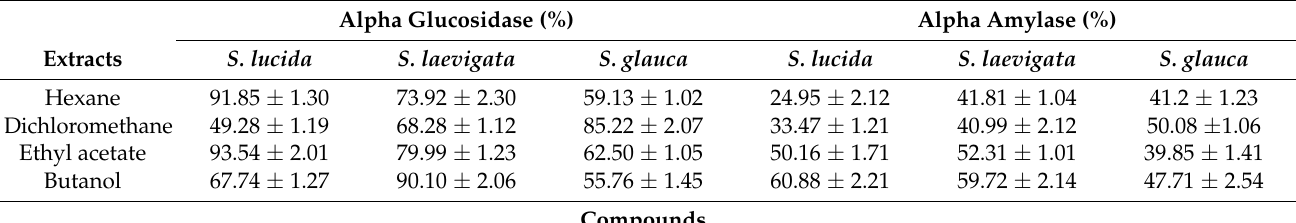
Table 3. Inhibitory activity (%) of Searsia ( S. lucida, S. laevigata, and S. glauca ) extracts on some carbohydrate digestive enzymes (alpha glucosidase and alpha amylase). Alpha Glucosidase (%) Alpha Amylase (%)